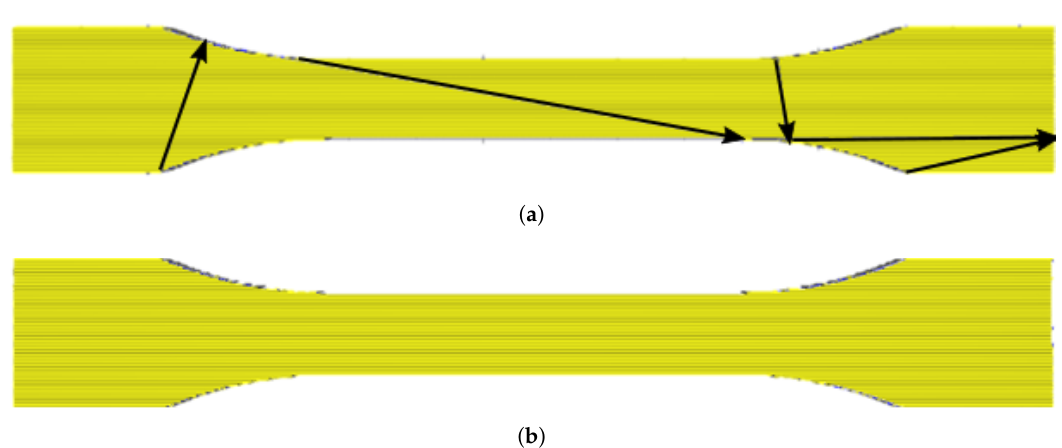
Figure 2. Simulation of production with two travel configuration setups by using arrows visualizing the travel of the nozzle. ( a ) Default setup with parameters from Table 4, black lines are travel lines, also depositing material, indicating weak points in the specimen. ( b ) Optimized setup, the travel lines are along the outer surface of the specimen.